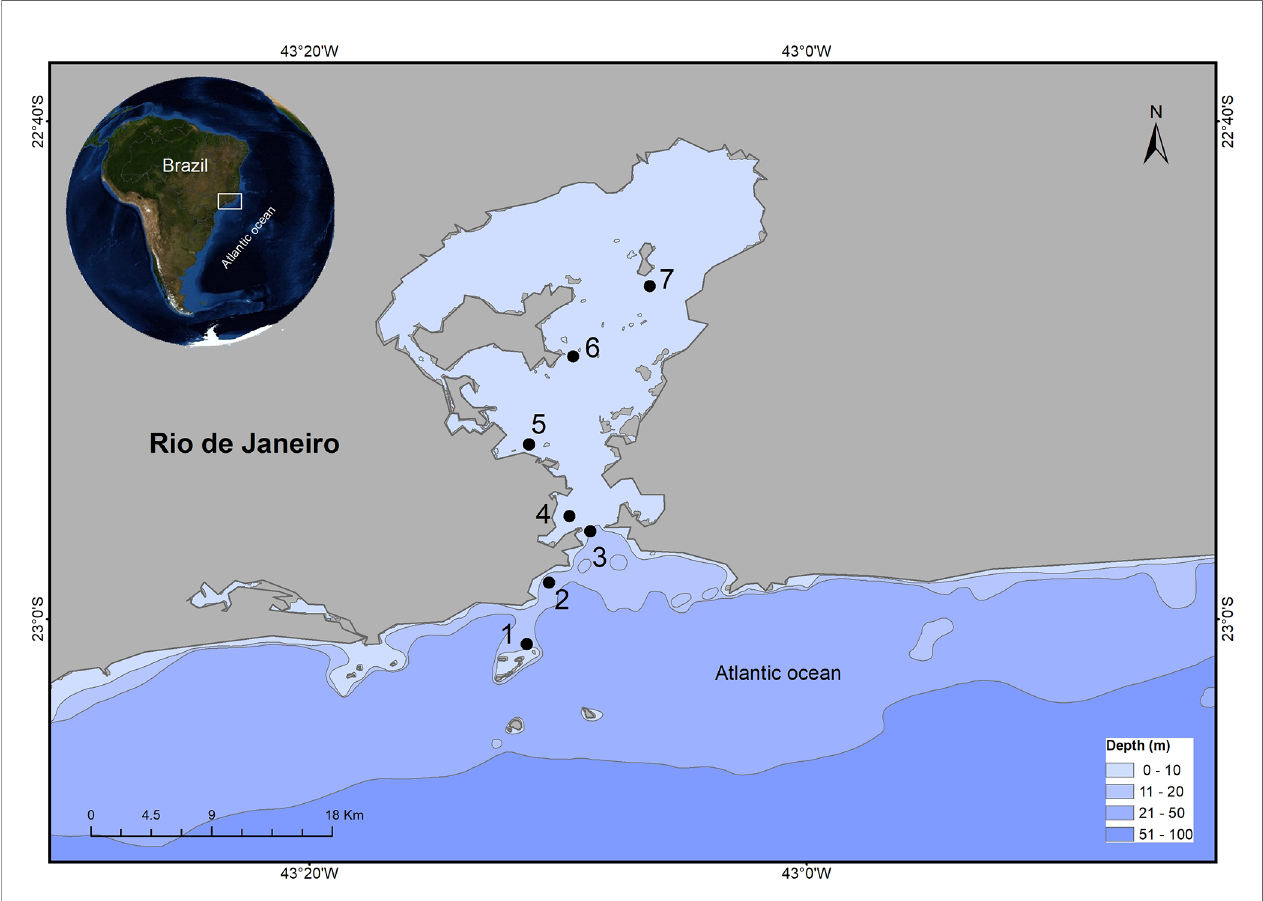
FIGURE 1 | Guanabara Bay shrimp, swimming crabs and squid sampling points: P1, Cagarras Island (23°03 ’ 24.86 ’’ S; 43°05 ’ 55.95 ’’ W); P2, Copacabana Beach (22°59 ’ 24.29 ’’ S; 43°09 ’ 05.57 ’’ W); P3, Urca Beach (22°54 ’ 10.12 ’’ S; 43°09 ’ 05.57 ’’ W); P4, Flamengo Beach (22°55 ’ 27.10 ’’ S; 43°09 ’ 02.43 ’’ W); P5, Seaport of Rio